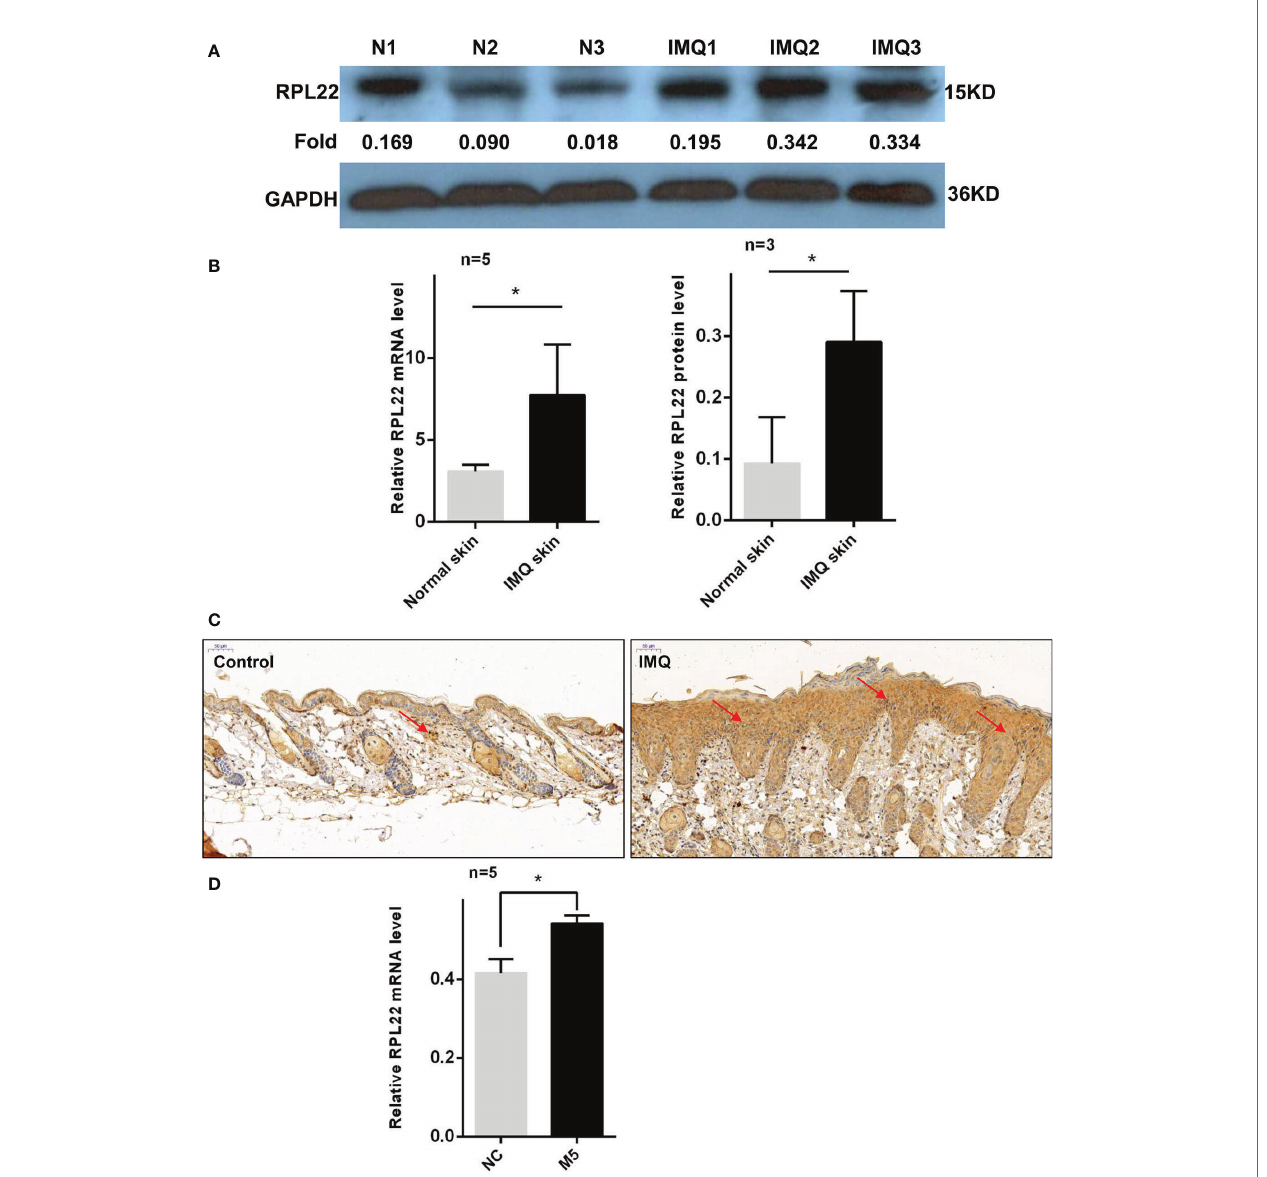
FIGURE 2 | RPL22 expression is elevated in skin lesions of IMQ mouse models. (A) The protein expression level of RPL22 in lesional skins from IMQ-exposed mice and vehicle-exposed mice. (B) The statistical analysis of the relative mRNA (left panel, n = 5) and protein expression levels (right panel, n = 3) of RPL22 in lesional skins from IMQ-exposed mice and vehicle-exposed mice. (C) IHC staining of RPL22 in lesional skins from IMQ-exposed mice vehicle-exposed mice. (D) The mRNA expression level of RPL22 in psoriatic-like cells model on HaCaT cells stimulating with a cocktail of cytokines including Oncostatin-M, IL-1 a , IL-17A, IL-22, and TNF- a (M5). Data (D) are representative of at least 3 independent experiments. Data represent the mean ± SEM. *P < 0.05. Two-tailed unpaired Student ’ s t test was